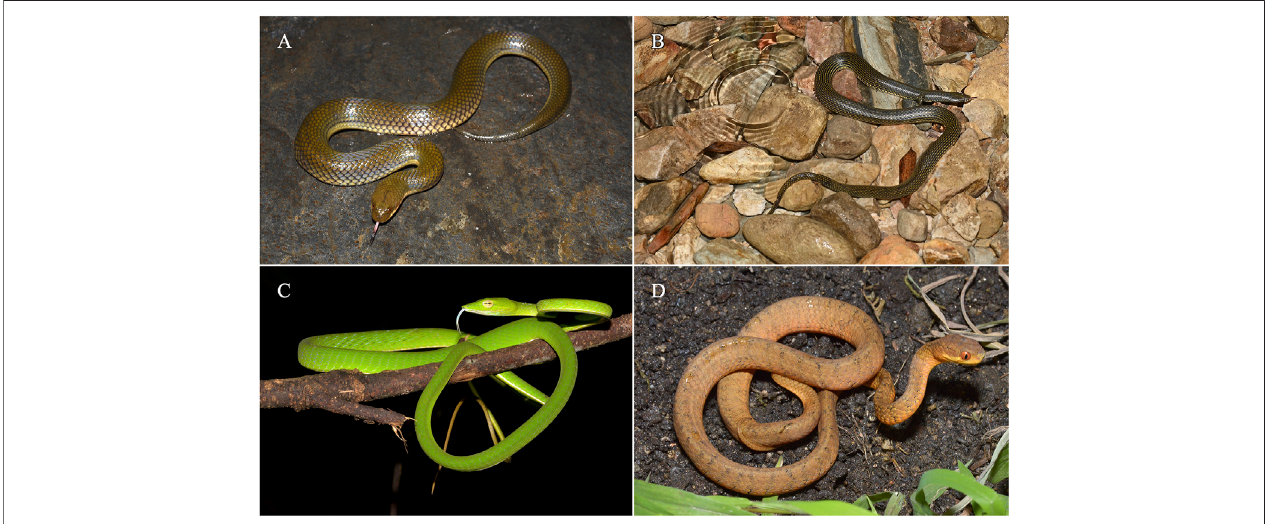
FIGURE1| Fourspecies ofsnakes inthestudy. (A) Hypsiscopusplumbea (aquatic). (B) Opisthotropiszhaoermii (aquatic). (C) Ahaetullaprasina (non-aquatic). (D) Pareas menglaensis (non-aquatic). Photos by Jin-Long Ren and Jun-Jie